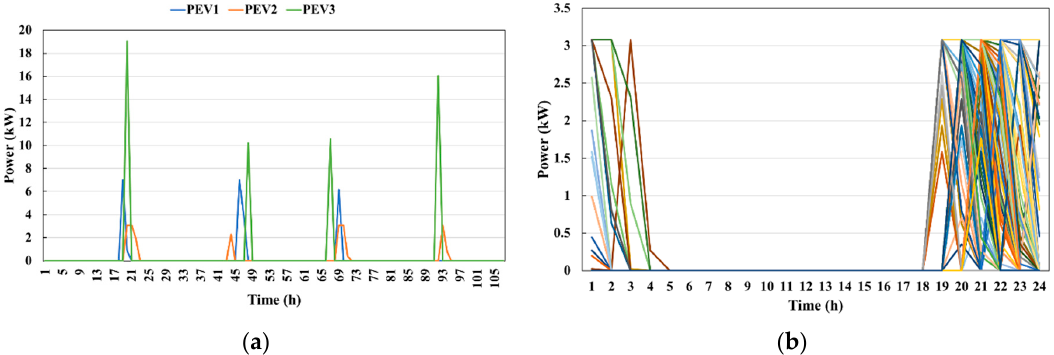
Figure 10. Example of an individual PEV charging demand model: ( a ) Charging profiles for three arbitrarily chosen PEVs; ( b ) Over ‐ rapped daily charging profiles of an arbitrary chosen PEV.